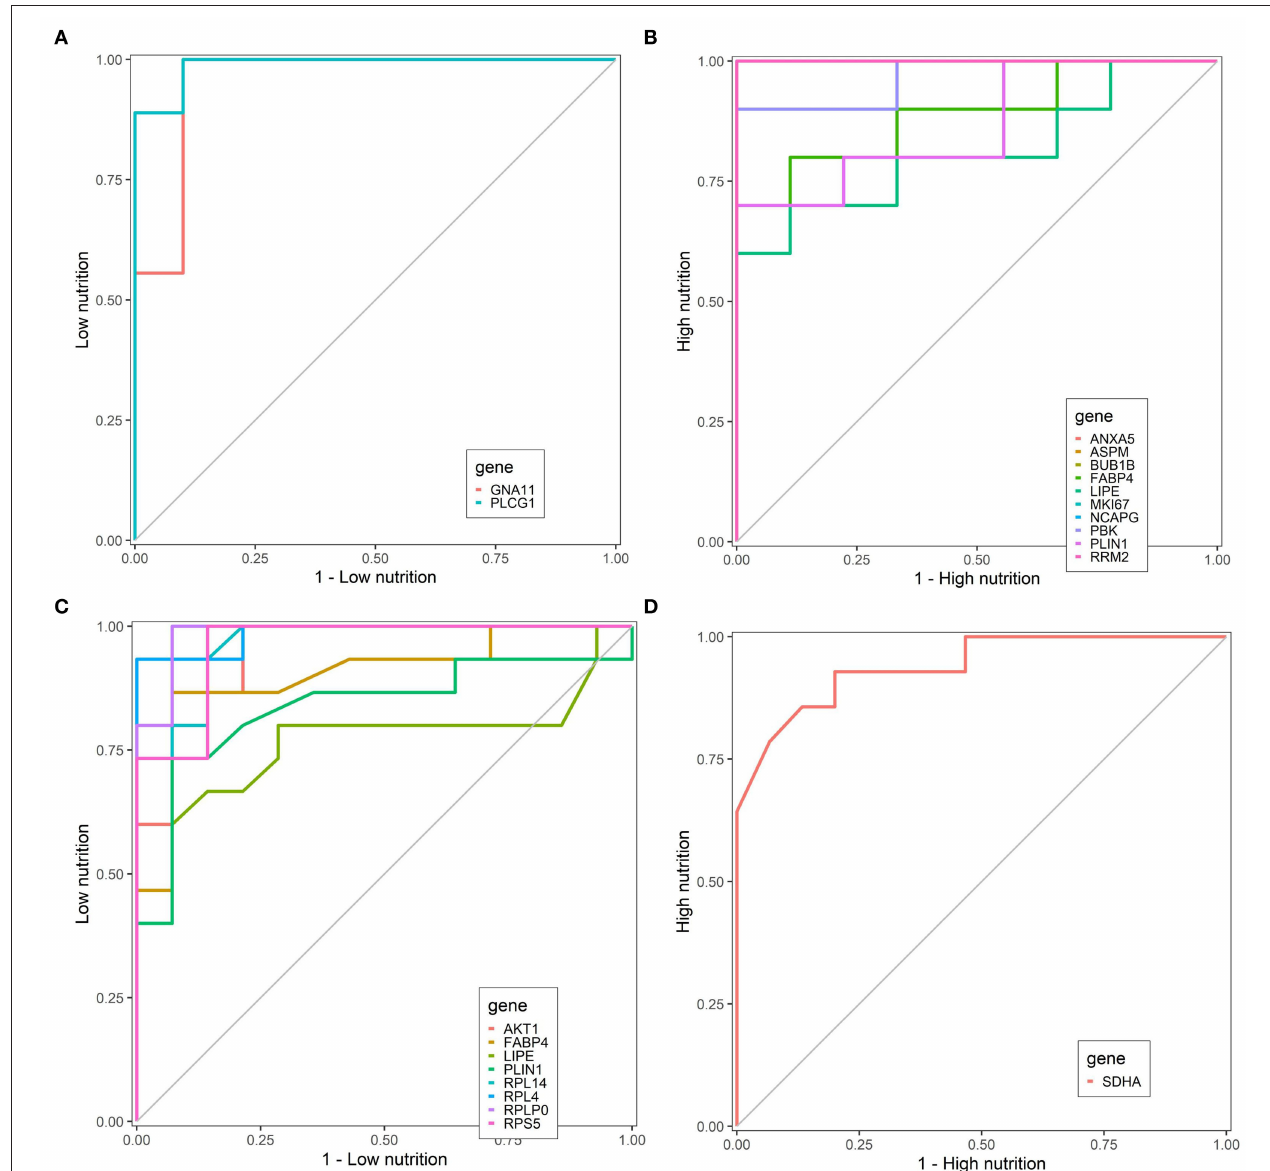
FIGURE 9 | Receiver operating characteristic (ROC) curve analysis of hub genes. Hub genes can distinguish low nutrition (A) and high nutrition (B) in subcutaneous adipose tissue, and hub genes can distinguish low nutrition (C) and high nutrition (D) in visceral adipose tissue. Genes are represented by different colored lines. The larger area under the curve indicates that the genes have a stronger ability to differentiate the high and low nutrition